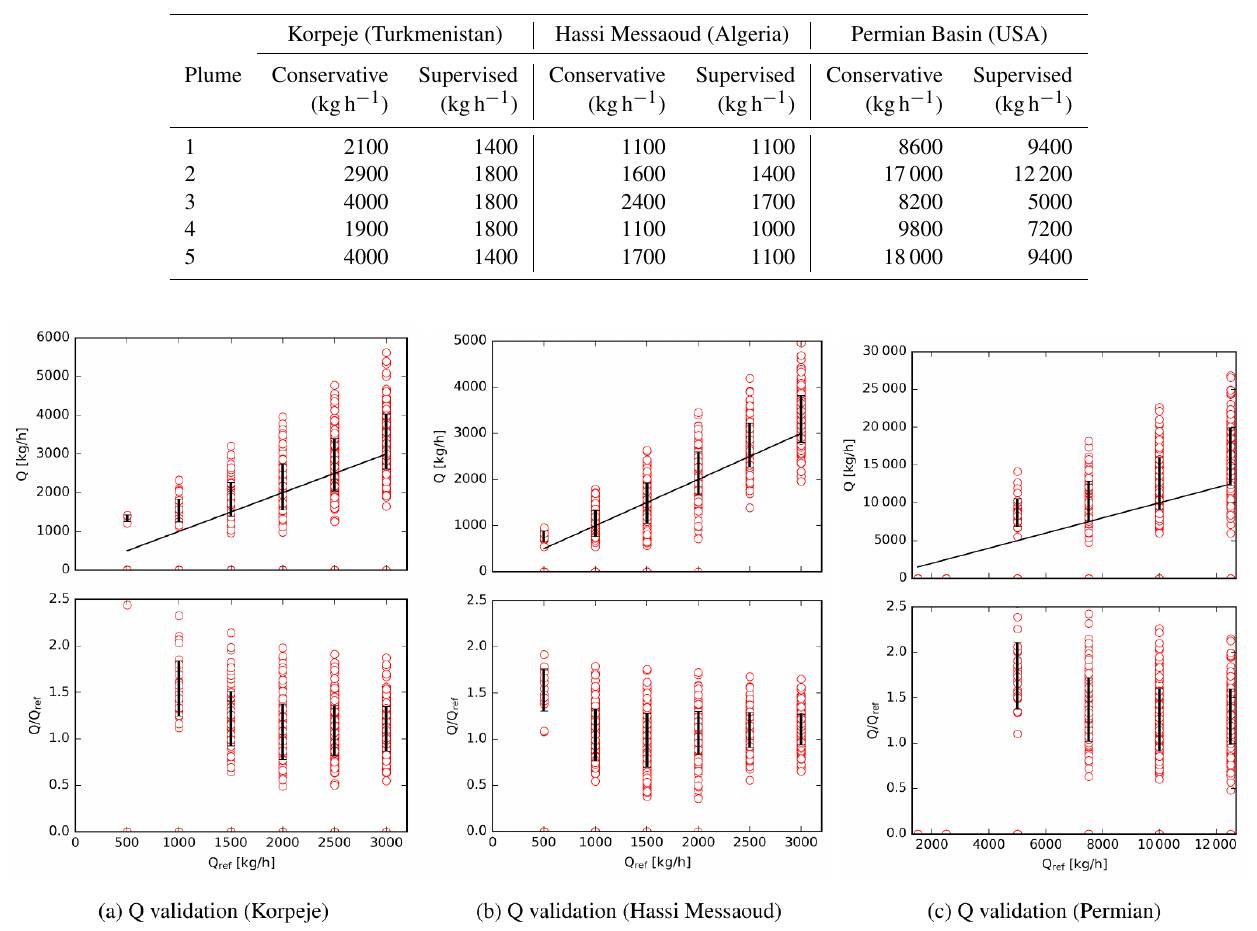
Figure 11. Q validation against reference values for 221 plume shapes with supervised detection masking criteria as detailed in Sect. 4. The graph also includes the mean and standard deviation of the errors at the selected flux rate